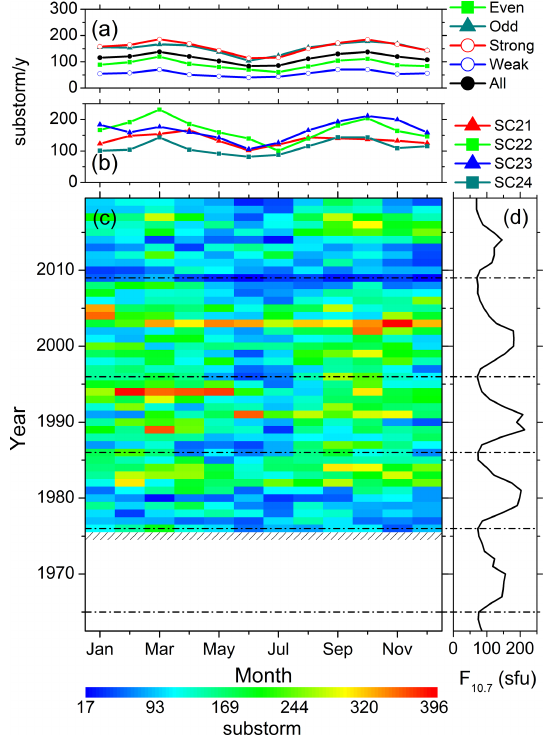
Figure 4. Substorms from 1976 to 2019. Panel (c) shows the year– month contour plot of the number of substorms in each month of the years 1976–2019. The values of different colors are given in the legend at the bottom. Data gaps are shown by crosses. Panel (d) shows the yearly mean F 10 . 7 solar flux. Panel (b) shows the monthly numbers of substorms per a year of observation during each solar cycles, and panel (a) shows the same during groups of the even, odd, strong, weak and all solar cycles. For details on the grouping of the solar cycles, see the text. The solar minima are marked by horizontal dot-dashed lines.